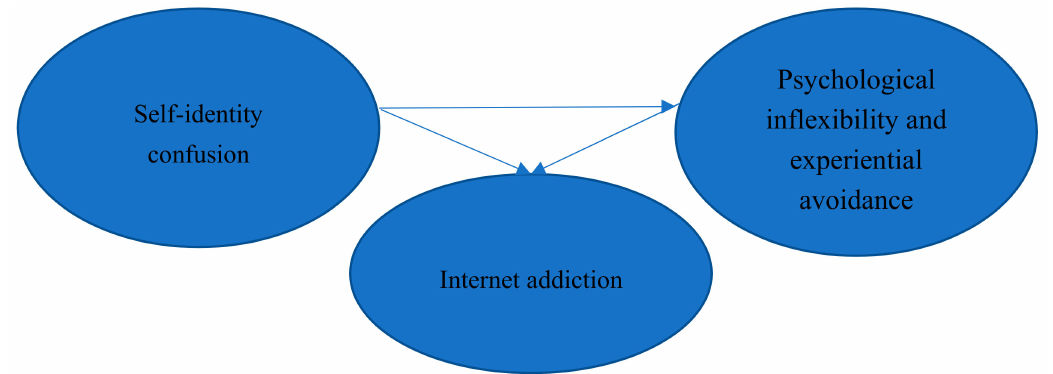
Figure 1. Hypothesized model of the associations among self-identity confusion, Internet addiction, and psychological inflexibility and experiential avoidance (PI /